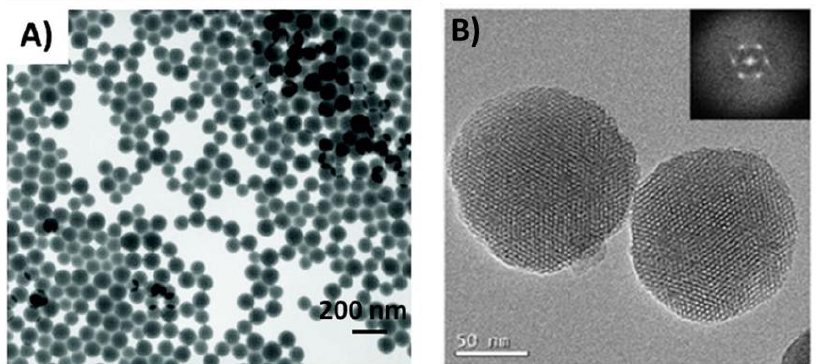
Figure 1. Transmission electron microscopy images of ( A ) nonporous silica nanoparticles (synthesised from SiO 2 using the Stöber method). Reprinted with permission from [8]. Copyright (2011) American Chemical Society. ( B ) isothiocyanate-functionalized mesoporous silica nanoparticle made of TEOS and 3-aminopropyl triethoxysilane. Reprinted from [9] .